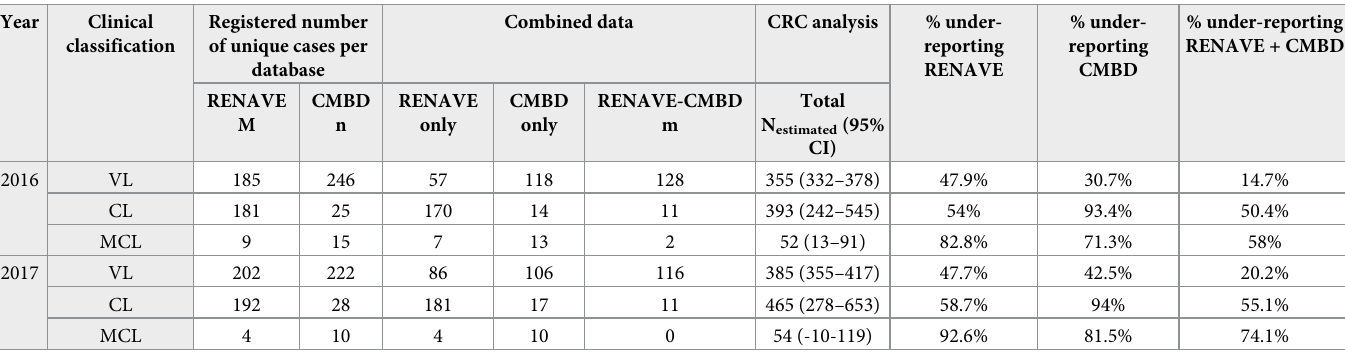
Table 3. Number of cases of leishmaniasis, by data source, after case-linkage, and combined estimates based on CRC analysis, Spain, 2016–2017. Year Clinical